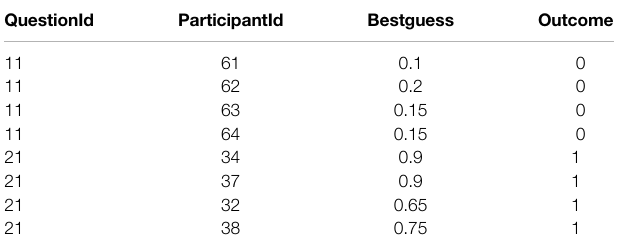
TABLE 1 | Excerpt of the complete data